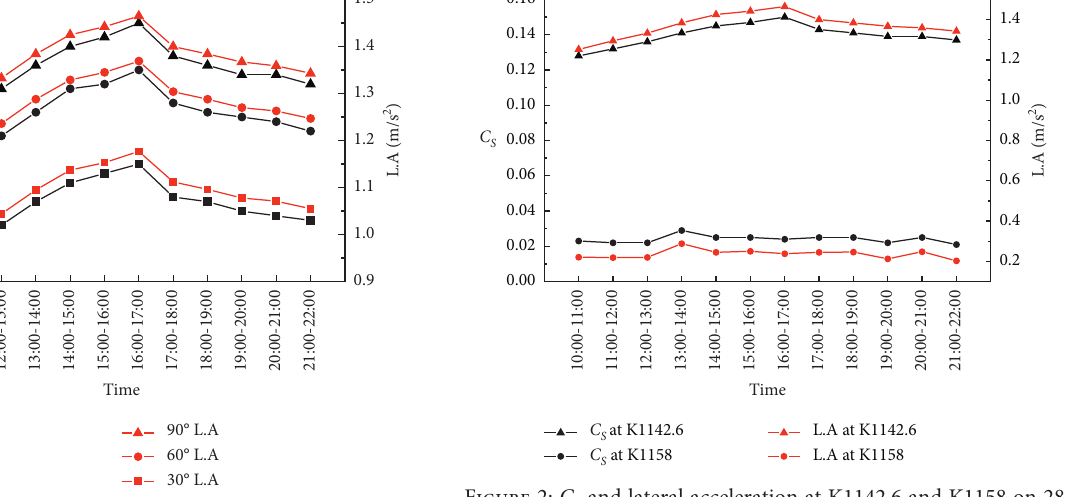
coefficient and lateral acceleration.